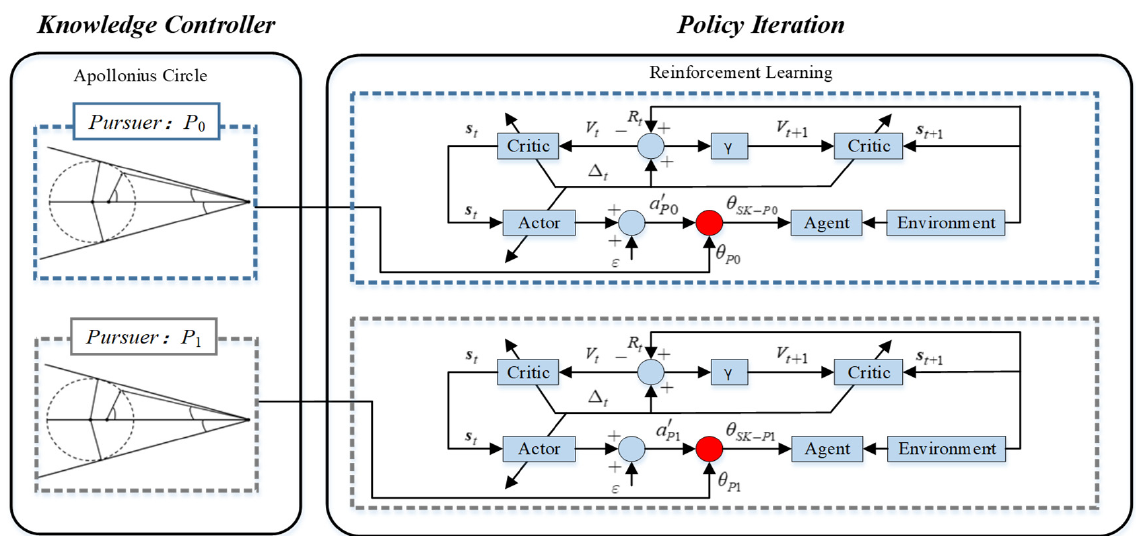
Figure 8. The learning logic of the proposed accelerating fuzzy actor–critic learning algorithm.